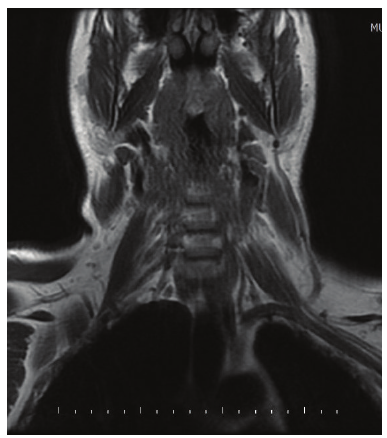
Figure 5: MRI was normal at the postoperative